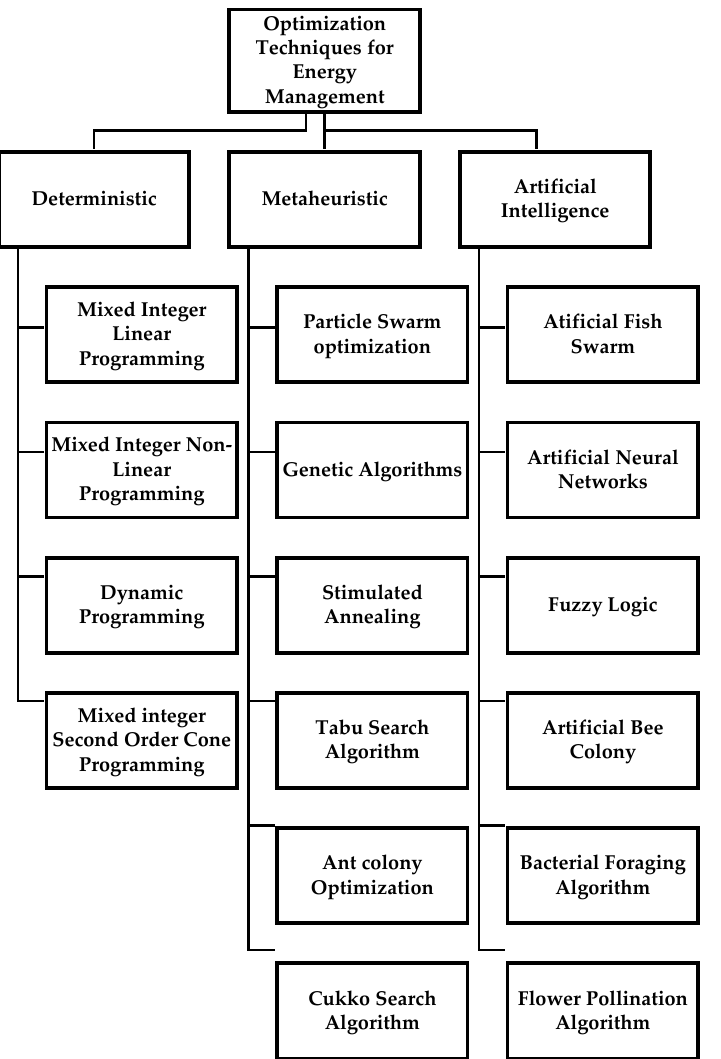
Figure 8. Classification of some important optimization algorithms for energy management.